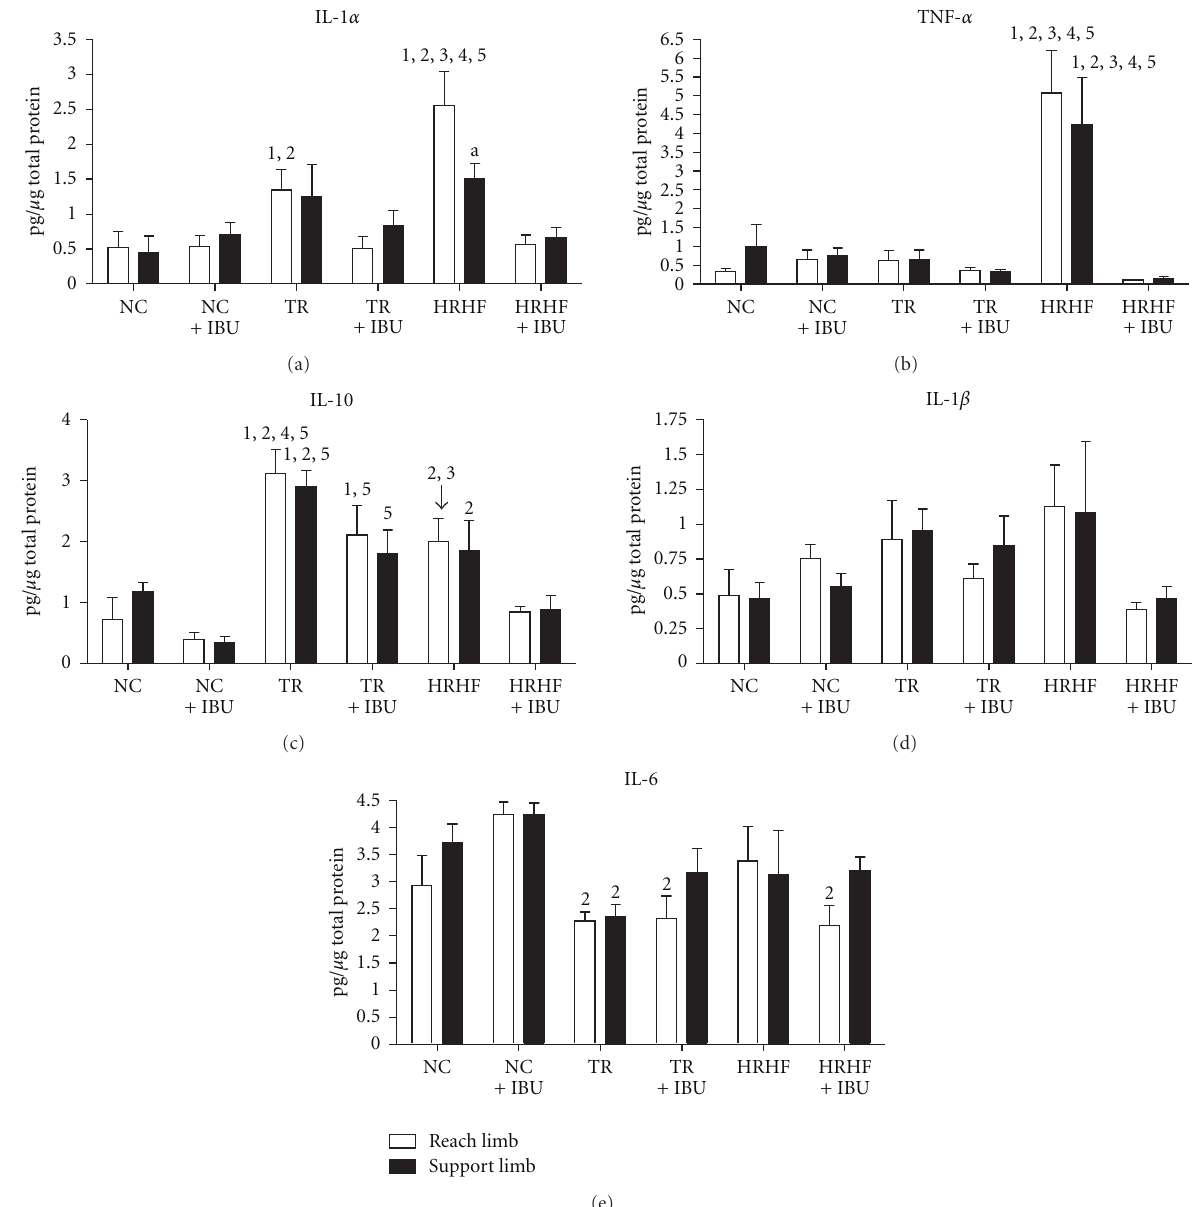
Figure 2: Cytokine concentrations in reach and support wrist joint (distal most radius, distal ulna, first row of carpal bones, and associated joint regions), tested using ELISA. Levels of (a) Interleukin (IL)-1 α , (b) tumor necrosis factor (TNF)- α , (c) IL-10, (d) IL-1 β , and (e) IL-6 are shown for NC (normal control), NC + IBU (normal controls receiving ibuprofen for 8 weeks), TR (trained controls), TR + IBU (trained controls receiving ibuprofen treatment in final 8 weeks), HRHF (rats performing high-repetition high-force task for 12 weeks), and HRHF + IBU (HRHF rats receiving ibuprofen treatment in final 8 weeks). Abbreviations: 1 = P < . 05 compared to NC, 2 = P < . 05 compared to NC + IBU, 3 = P < . 05 compared to TR; 4 = P < . 05 compared to TR + IBU; 5 = P < . 05 compared to HRHF + IBU; a = support limb is significantly di ff erent from reach limb, P < .